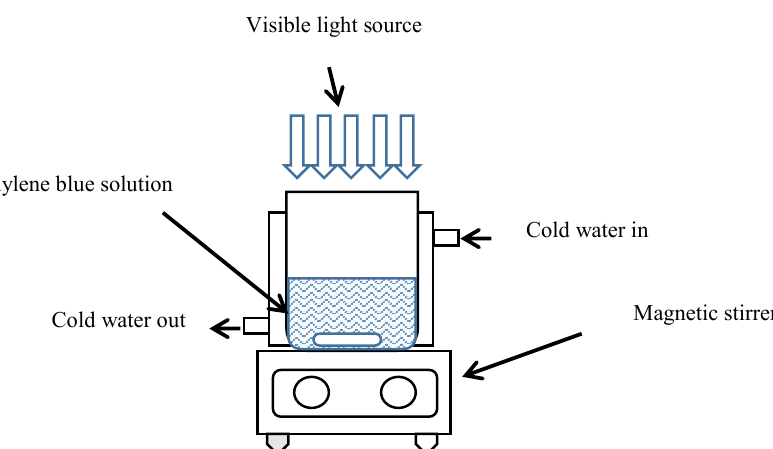
Fig. 1. Schematic diagram of slurry Fig. 1: Schematic diagram of slurry photoreactor.